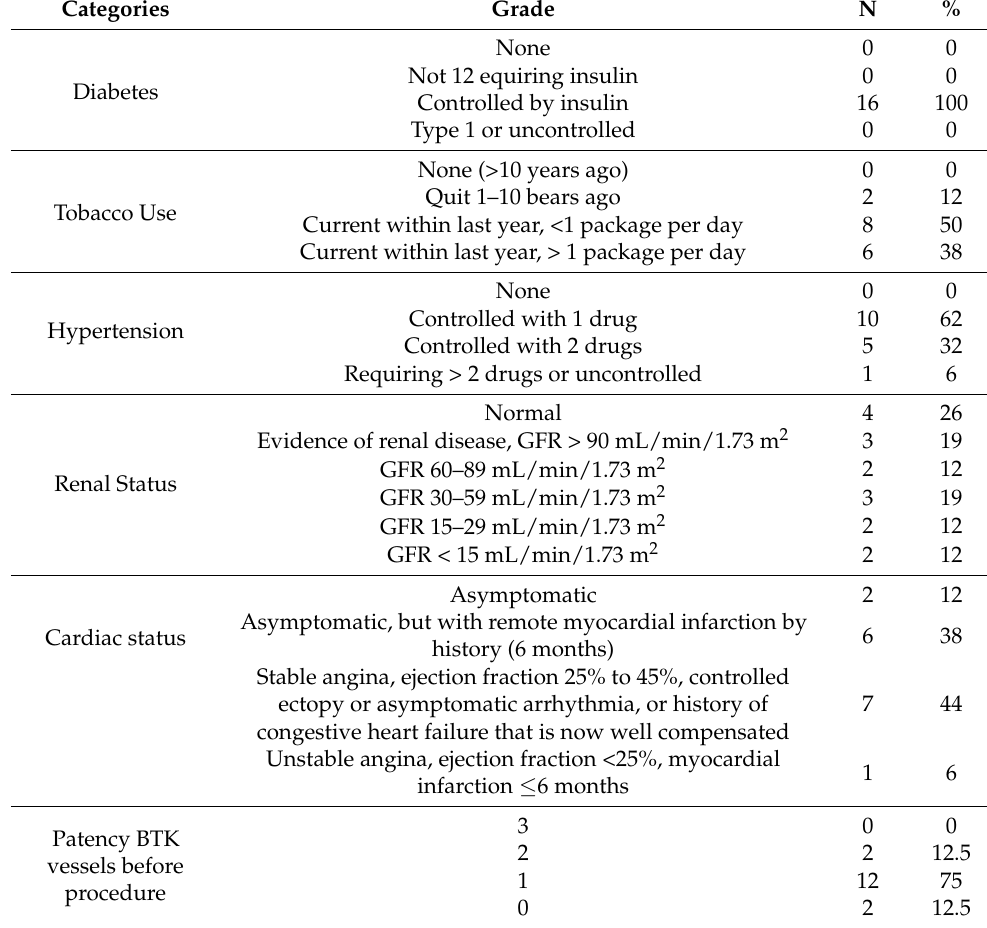
Table 6. Variables in patient with major amputation (16 patients).